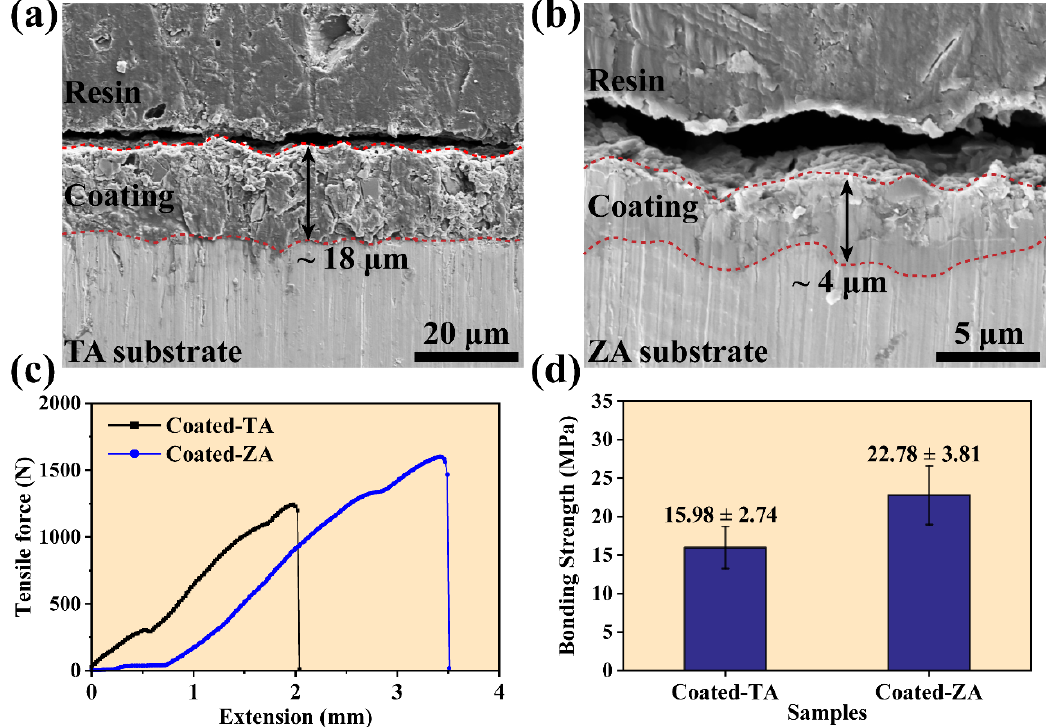
Figure 3. The cross ‐ sectional FE ‐ SEM micrographs and thickness of the ZnP coatings on ( a ) TA Figure 3. The cross-sectional FE-SEM micrographs and thickness of the ZnP coatings on ( a ) TA and and ( b ) ZA samples, ( c ) tensile ‐ extension curves, and ( d ) bonding strength variation of ZnP coat ‐ ( b ) ZA samples, ( c ) tensile-extension curves, and ( d ) bonding strength variation of ZnP coatings on ings on TA and ZA samples. TA and ZA